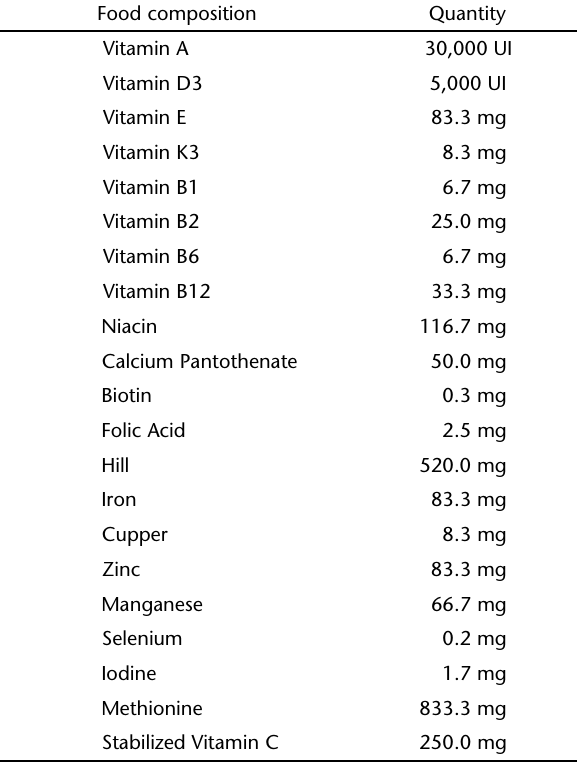
Table I. Composition of the fish food Alcon Basic ® used as organic matter source for the maintenance of B. sowerbyi in laboratory. Figures provided by the manufacturer (value per kilogram of the